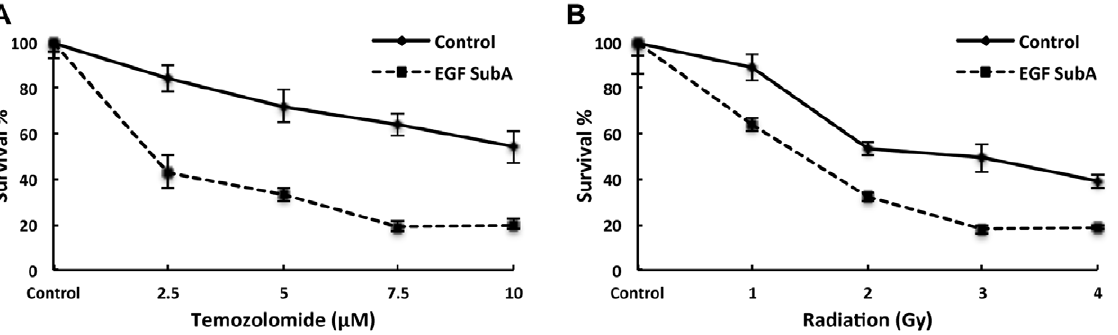
Figure 4. EGF-SubA enhances anti-tumor activity of temozolomide and ionizing radiation. A clonogenic assay was performed to evaluate the potential of EGF-SubA to enhance temozolomide (A) (statistically significant p , 0.0001) and radiation-induced (B) cytotoxicity (statistically significant p , 0.0024). U251 cells were seeded in six well culture plates and exposed to 1 pM of EGF-SubA 16 h prior to the addition of temozolomide or radiation exposure. Fresh media was then replaced in the culture plates after 8 h, and surviving fractions were calculated 10 to 14 d following treatment, normalizing for the individual cytotoxicity of EGF-SubA. Each figure is a representative of three independent experiments.